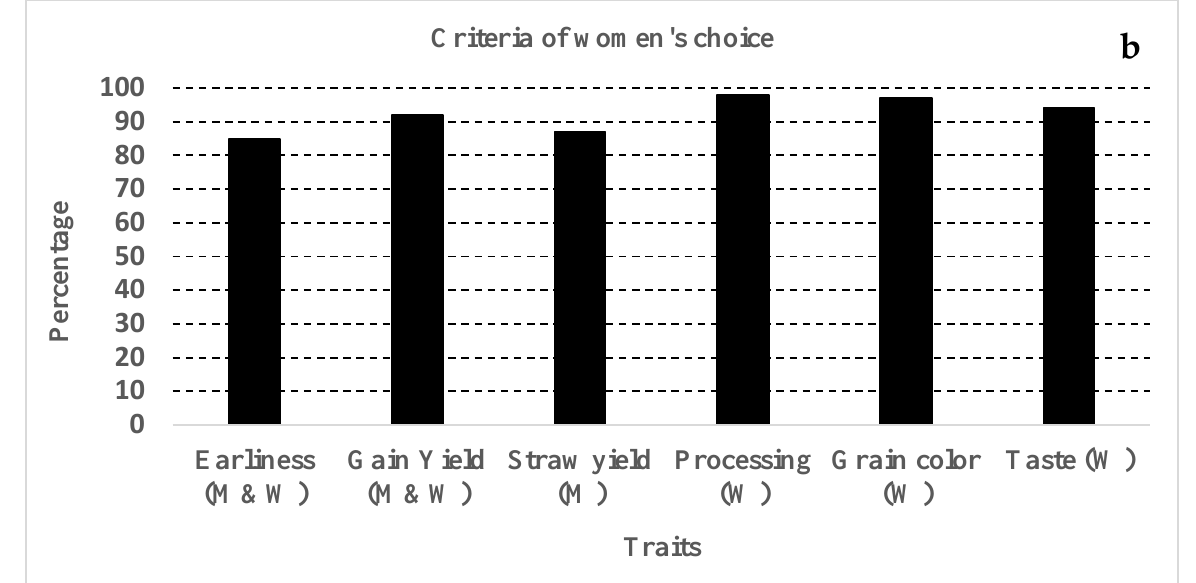
Figure 5. Criteria used by male ( a ) and female ( b ) farmers in Yaguine, Gory, and Foungou for selecting varieties, from the 2013/2014 to the 2015/2016 cropping seasons. The PI gives an overall assessment of a variety. In the 2013/2014 season, men ranked the varieties from 10 to 82 (mean 44.6), whereas women gave a PI ranging from 17 to 78 (mean 49.3) (Table 9). Table 9. Preference Index (%) of 54 sorghum varieties tested in Yaguiné, Gory, and Foungou in the 2013/2014 cropping season.